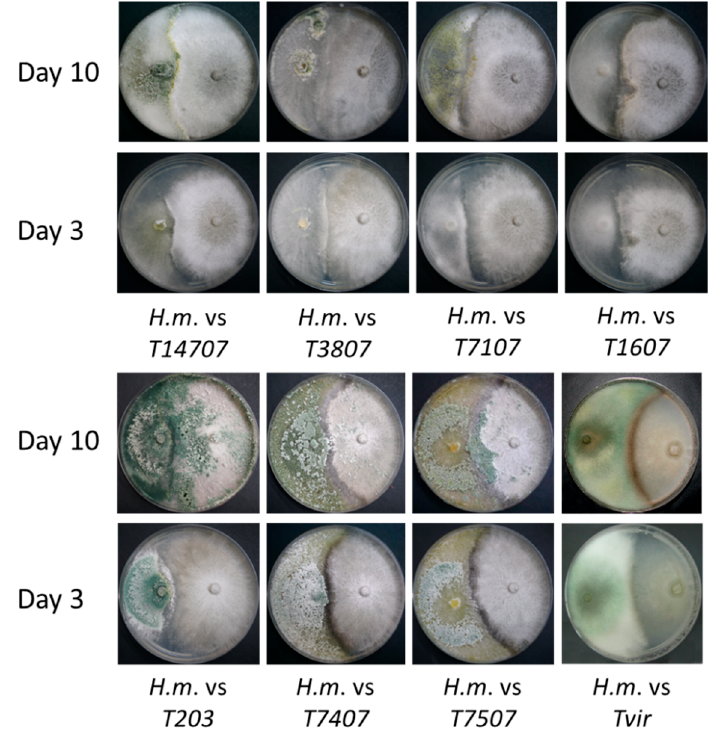
Figure 1. Plate mycoparasitism assays. The plate assay to identify the interactions between Magnaporthiopsis maydis and Trichoderma spp. in a rich potato dextrose agar (PDA) culture medium. The two fungi were planted opposite to each other, Trichoderma spp. on the left and M. maydis on the right. Images were taken at 3 and 10 days of growth.